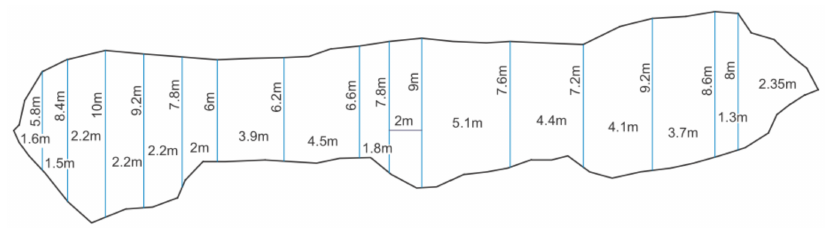
Figure 4. Crater outline and length measured after the rupture test (This figure was published from Applied Energy , Liu et al. [42], Copyright: Elsevier,